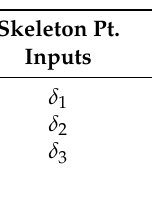
Table 2. Inputs of each value